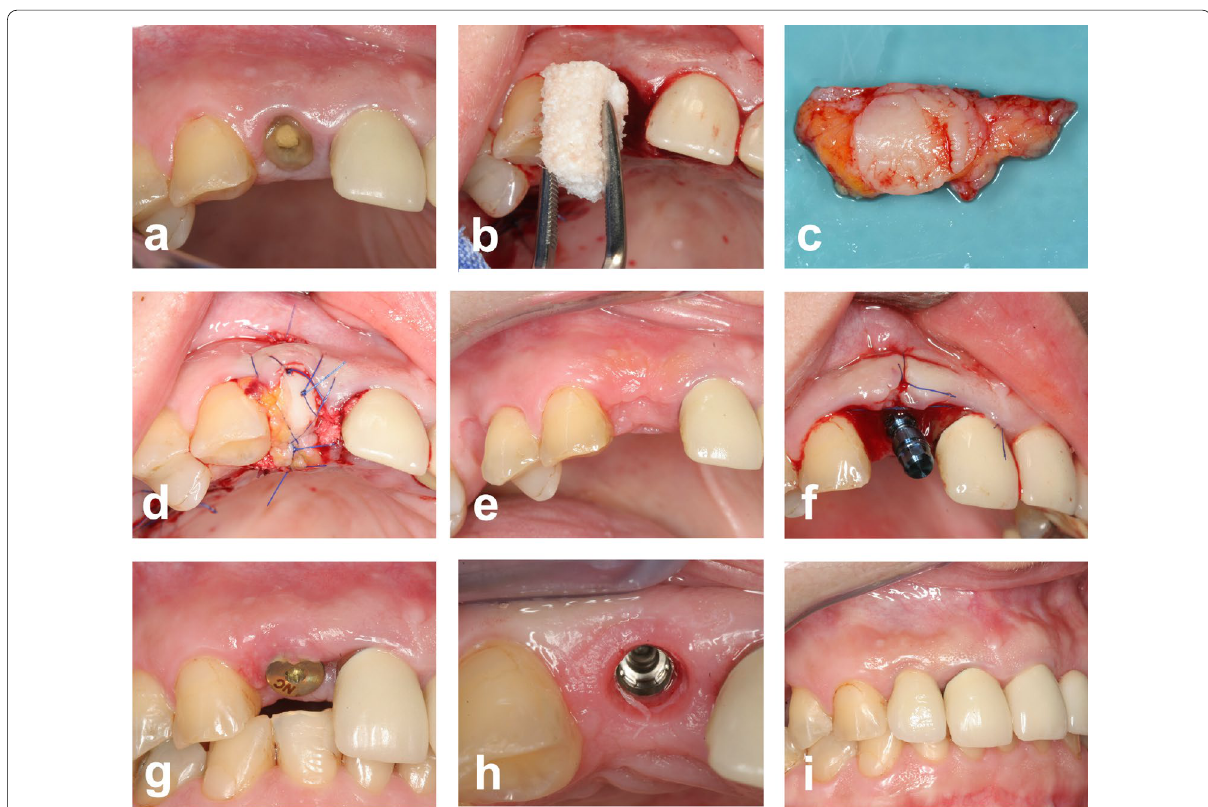
Fig. 1 CECG group. a Clinical situation prior to tooth removal, b extraction socket is filled up to the bony margin with a xenogenic bone graft substitute, c autologous combined connective tissue-mucosal graft is harvested from the palate, d extraction socket is covered with the graft, palatal and buccal pouch, e clinical situation after healing, f implant placement without further grafting, g clinical situation after second stage surgery, h emergence profile, i prosthetic